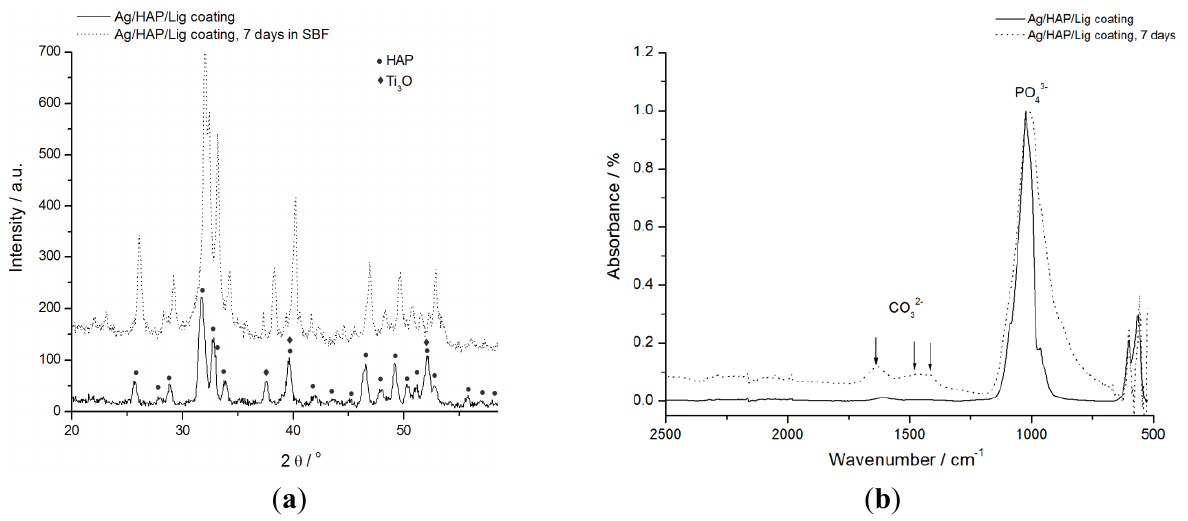
Figure 4. ( a ) XRD patterns and ( b ) attenuated total reflection Fourier transform infrared spectroscopy (ATR-FTIR) spectra of sintered Ag/HAP/Lig coating, before and after 7 days immersion in SBF at 37 °C. Reprinted from [39] with permission. Copyright American Chemical Society